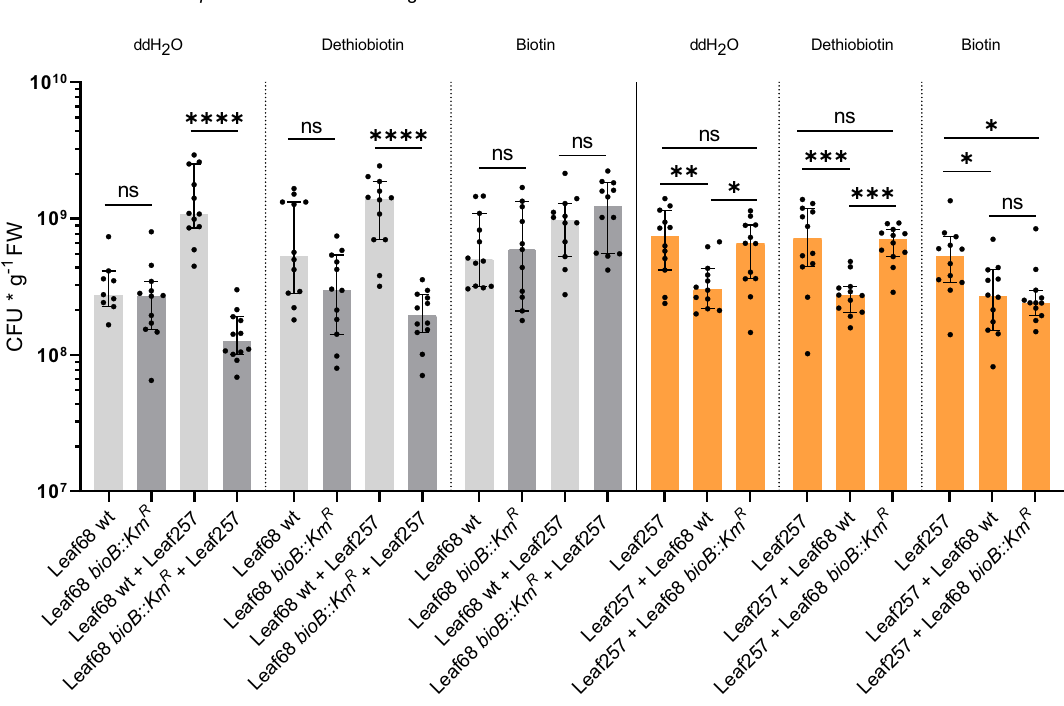
Fig. 5 In planta biotin complementation assays and interaction with Sphingomonas Leaf257. a Competition assay depicting the percentage (%) of total population of Rhizobium Leaf68 wild type (light gray) versus Leaf68 bioB::Km R (dark gray) without treatment (control), mock treatment (ddH 2 O) and biotin treatment post inoculation (p.i) (see methods). For statistical analysis a two-sided paired t-test was performed. A 1:1 mixture is indicated at 50% with the red dotted line. b Depiction of the bacterial colonization (CFUs per gram fresh weight) for Leaf68 wild type (light gray), Leaf68 bioB::Km R (dark gray), Sphingomonas Leaf257 (orange) during mono- and co-colonization and mock (ddH 2 O) treatment of the plant. c Bacterial colonization (CFUs per gram fresh weight) of Leaf68 (light gray), Leaf68 bioB::Km R (dark gray) and Leaf257 (orange) during mono- and co-colonization treatment with either ddH 2 O, dethiobiotin or biotin in planta (see “ Methods ” ). Each data point represents the CFUs of a single plant with a total of 12 plants for this experiment, except for the mock (ddH 2 O) in A due to a contamination. In all graphs, the median and 95% con fi dence interval are shown. For ( b , c ), statistical analysis was performed using the Kruskal – Wallis test ( P -values: * p -value < 0.05, ** p -value < 0.01, *** p -value < 0.001, and **** p -value < 0.0001). Source data are provided as a Source data fi